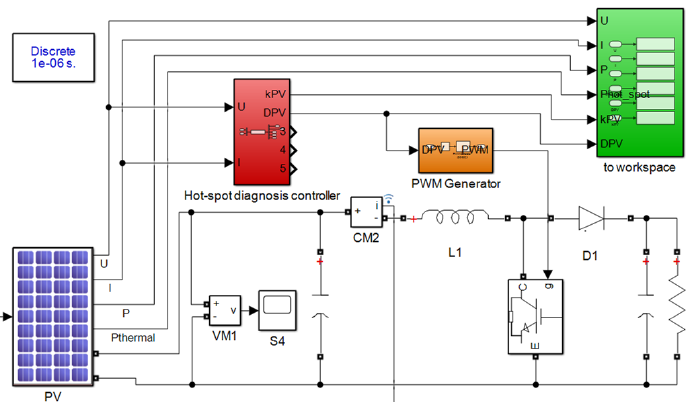
Figure 9. Simulation diagram of photovoltaic control system based on low resistance hot-spot fault diagnosis.